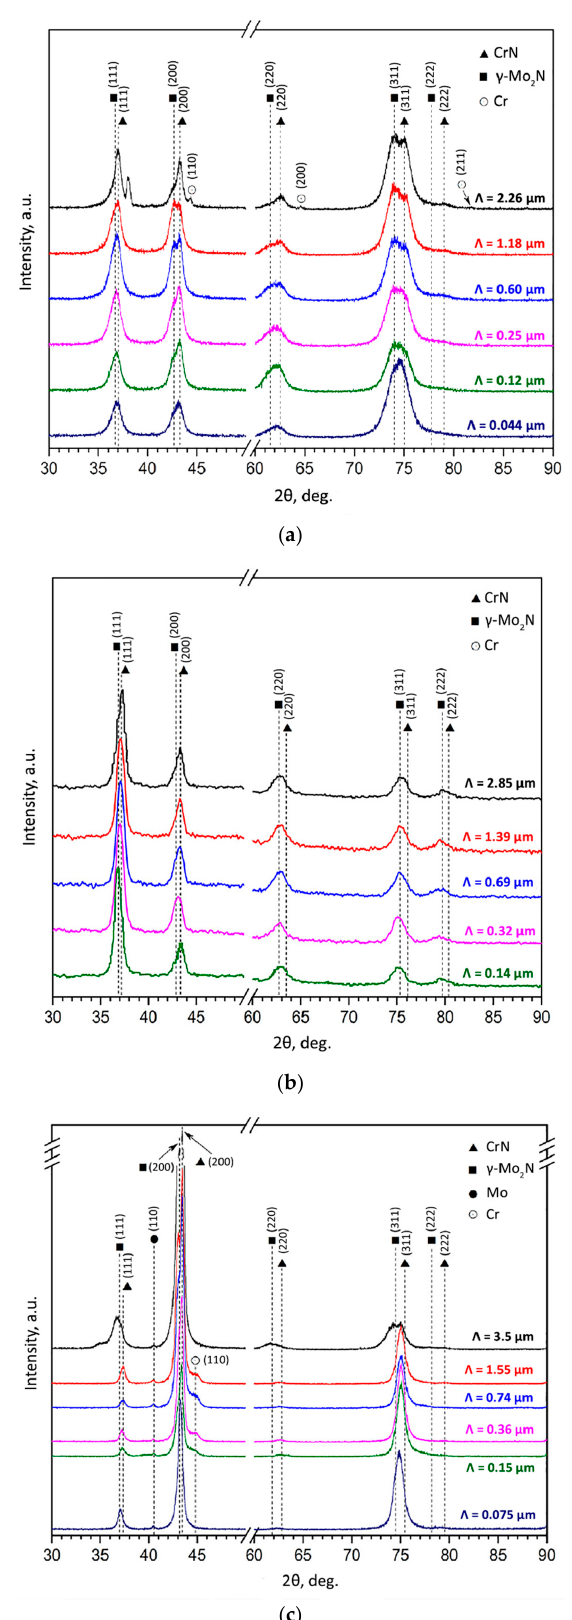
Figure 13. XRD patterns for CrN/MoN coatings deposited at different bias voltage: ( a ) − 20 V; ( b ) − 150 V; ( c ) − 300 V. Reprinted with permission from [100] 2018 Elsevier.